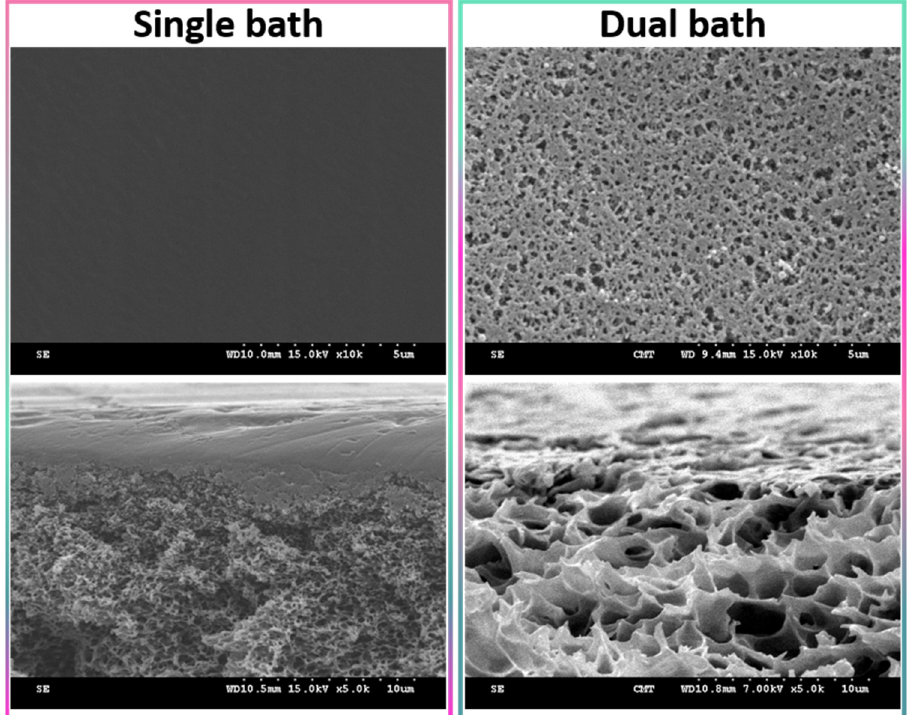
Figure 4. Surface of a polysulfone membrane prepared using DMF as solvent and either water as the sole non-solvent (single bath procedure) or both methanol and water as non-solvents (dual bath procedure). Top images present the surface, while the bottom images show the cross-section in the upper region.